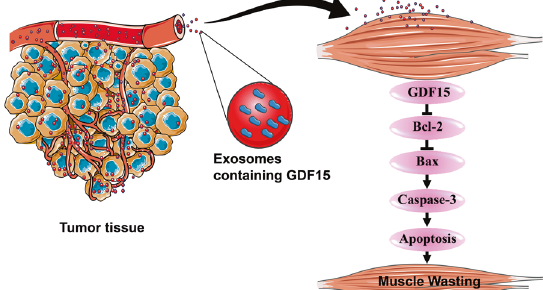
Fig. 8 Illustration of the mechanisms of exosome GDF15 in inducing muscle atrophy. Exosomes derived from cachexic C26 cells containing abundant GDF15 which could induce muscle wasting via activating Bcl-2/caspase-3-based apoptosis pathway in